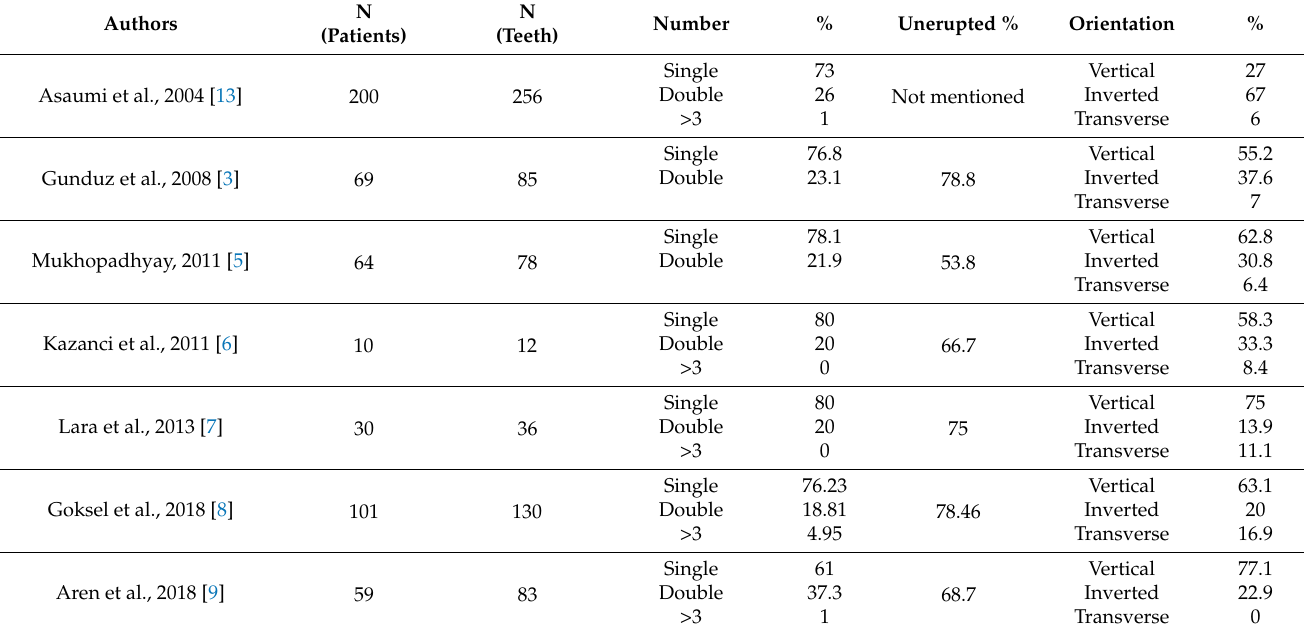
Table 2. Characteristics of mesiodens.